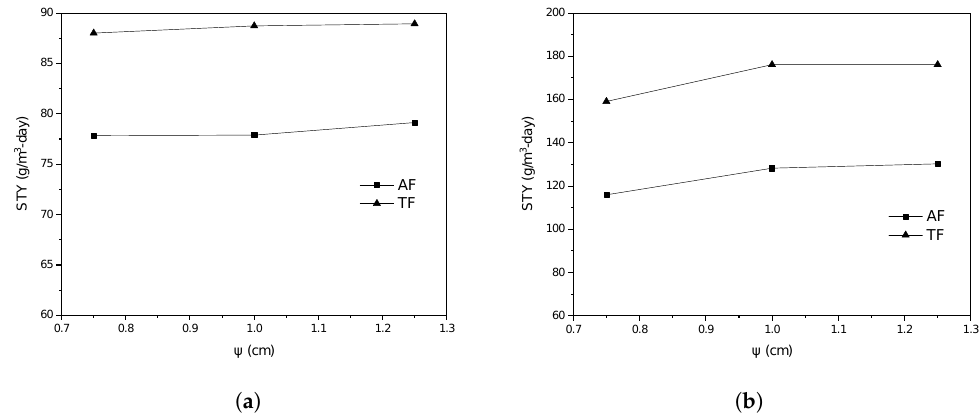
Figure 12. Effect of ψ and photoreactor flow configuration in Space-time Yield in ( a ) laminar and ( b ) turbulent